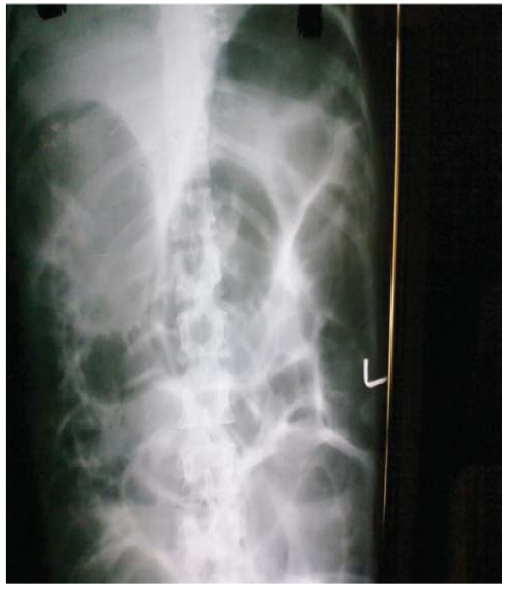
Figure 1: Abdominal radiograph showing a gross dilatation of the large and small bowel with mucosal edema Flexible sigmoidoscopy revealed irregular mucosal swelling with a stricture 10 cm above the anal verge, which impededed the further advancement of the scope. There was no active bleeding at the time of the examination. Abdominal computed tomography (CT) showed a suspicious lesion in the recto-sigmoid junction of the colon with regional enlarged lymph nodes and ascites. The patient was taken up for emergency laparotomy after resuscitation with a provisional diagnosis of acute large bowel obstruction. At surgery, severe (cid:2) brosis over the Douglas pouch and pelvic cavity was noted. A chocolate cyst of 3 X 3 cm was present in each of the ovaries with an intraperitoneal rupture of the left ovarian cyst and a grade IV endometriosis (Figure 2).